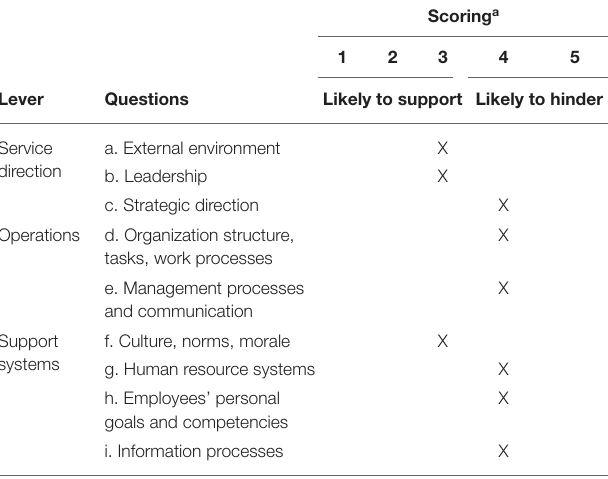
TABLE 2 | Organizational change readiness assessment